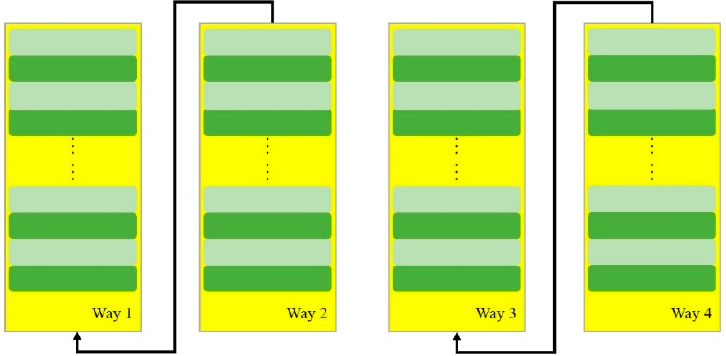
Figure 7. Associativity reconfigurable cache with a fixed size.